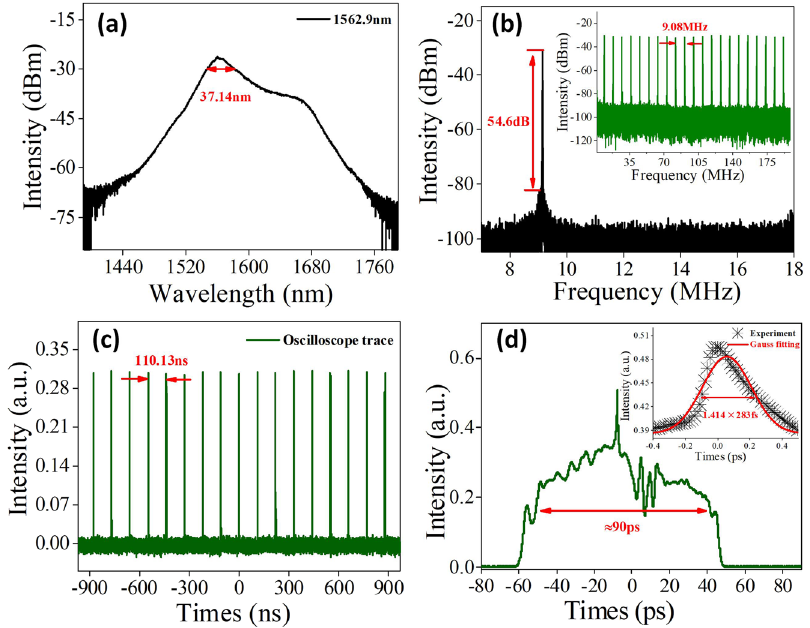
Figure 8: Mode-locking characteristics of NLP, (a) the optical spectrum of NLP state, (b) the RF spectrum of NLP state. (c) Mode- locked pulse trace of NLP state at 950 mW, (d) autocorrelation trace of NLP state at 950 mW.